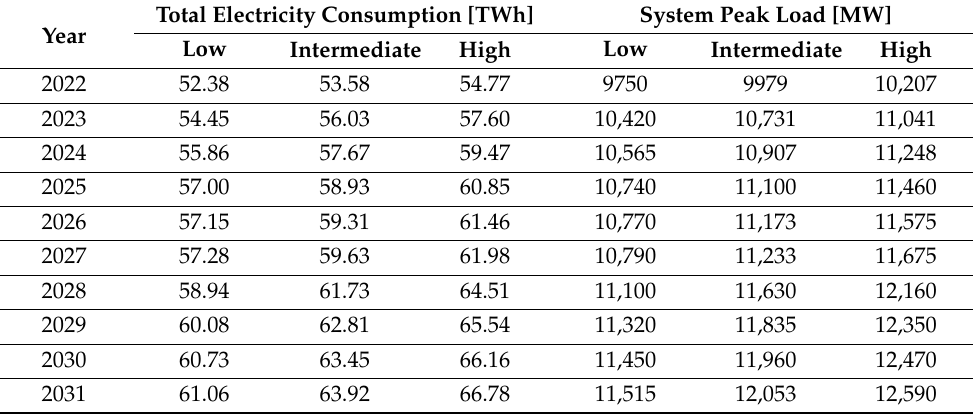
Table A1. System Load Data.